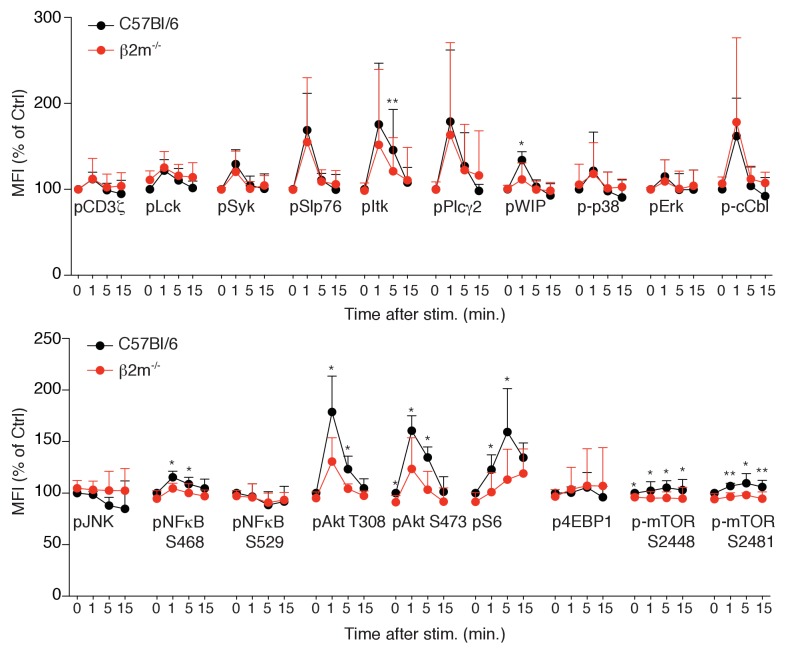
Phosphorylation level of phospho-epitopes defined in Table 1 was measured by flow-cytometry in splenic NK cells from C57BL/6 or B2m−/− mice following NK1.1 stimulation for the indicated time.MFI of the indicated phospho-epitope (mean + SD) of 5 mice of each genotype in five independent experiments (t-test, *p<0.05, **p<0.01).